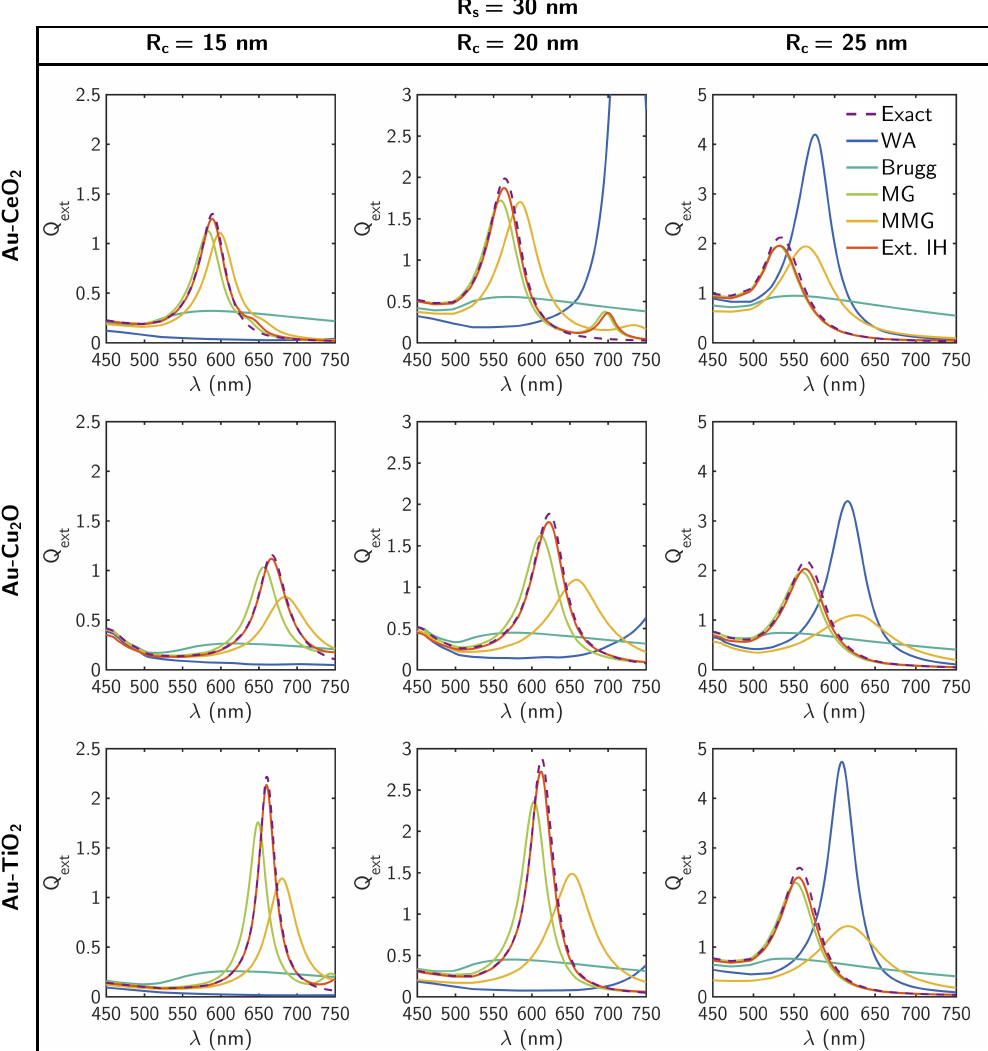
Figure 6. Extinction efficiency ( Q ext ) of Au-CeO 2 (top row), Au-Cu 2 O (middle row) and Au-TiO 2 (bottom row) core-shells of total radius R s = 30 nm and different core sizes: R c = 15 nm (first column), R c = 20 nm (middle column) and R c = 25 nm (right column). The exact solution is compared with different effective medium theories: weighted average (WA), Bruggeman (Brugg), Maxwell Garnett (MG), Mie theory based Maxwell Garnett (MMG) and the proposed approach (Ext.